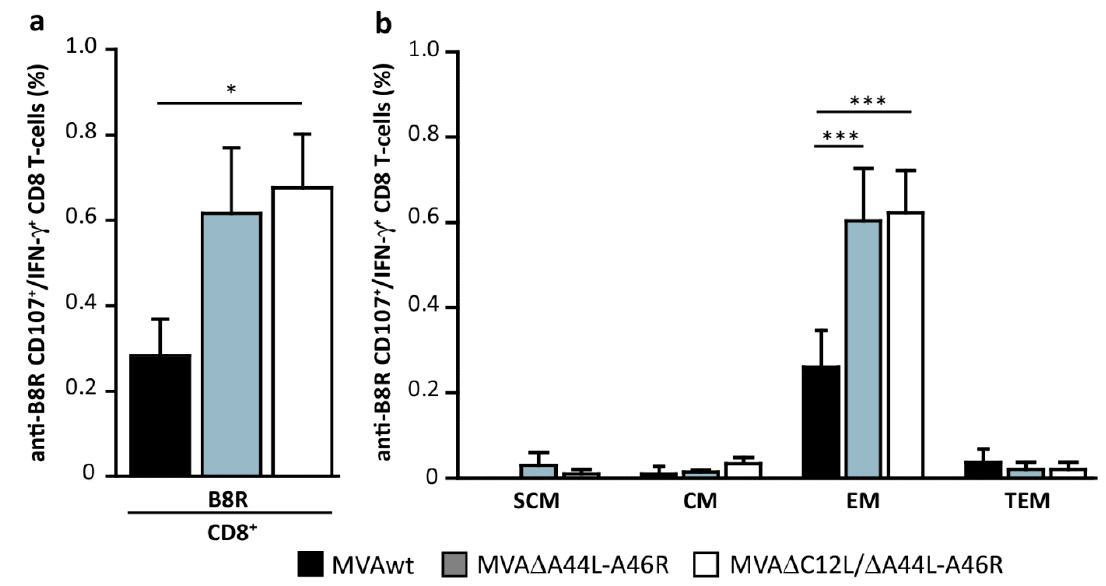
Figure 5. Modulation of specific responses in memory T-cell subpopulations. ( a ) Forty five days after immunization, splenocytes from immunized mice, were stimulated with B8R peptide. Percentage of double-positive (CD107 a/b+ / IFN- γ + ) CD8 + T-cells was analyzed by flow-cytometry. ( b ) Distribution of memory-subpopulations among bifunctional B8R-specific T-cells, classified as follows: “early-memory (cid:1) or T stem-cells memory” (T SCM ; CD44L /CD62L + ), T central memory (T CM ; CD44 + /CD62L +